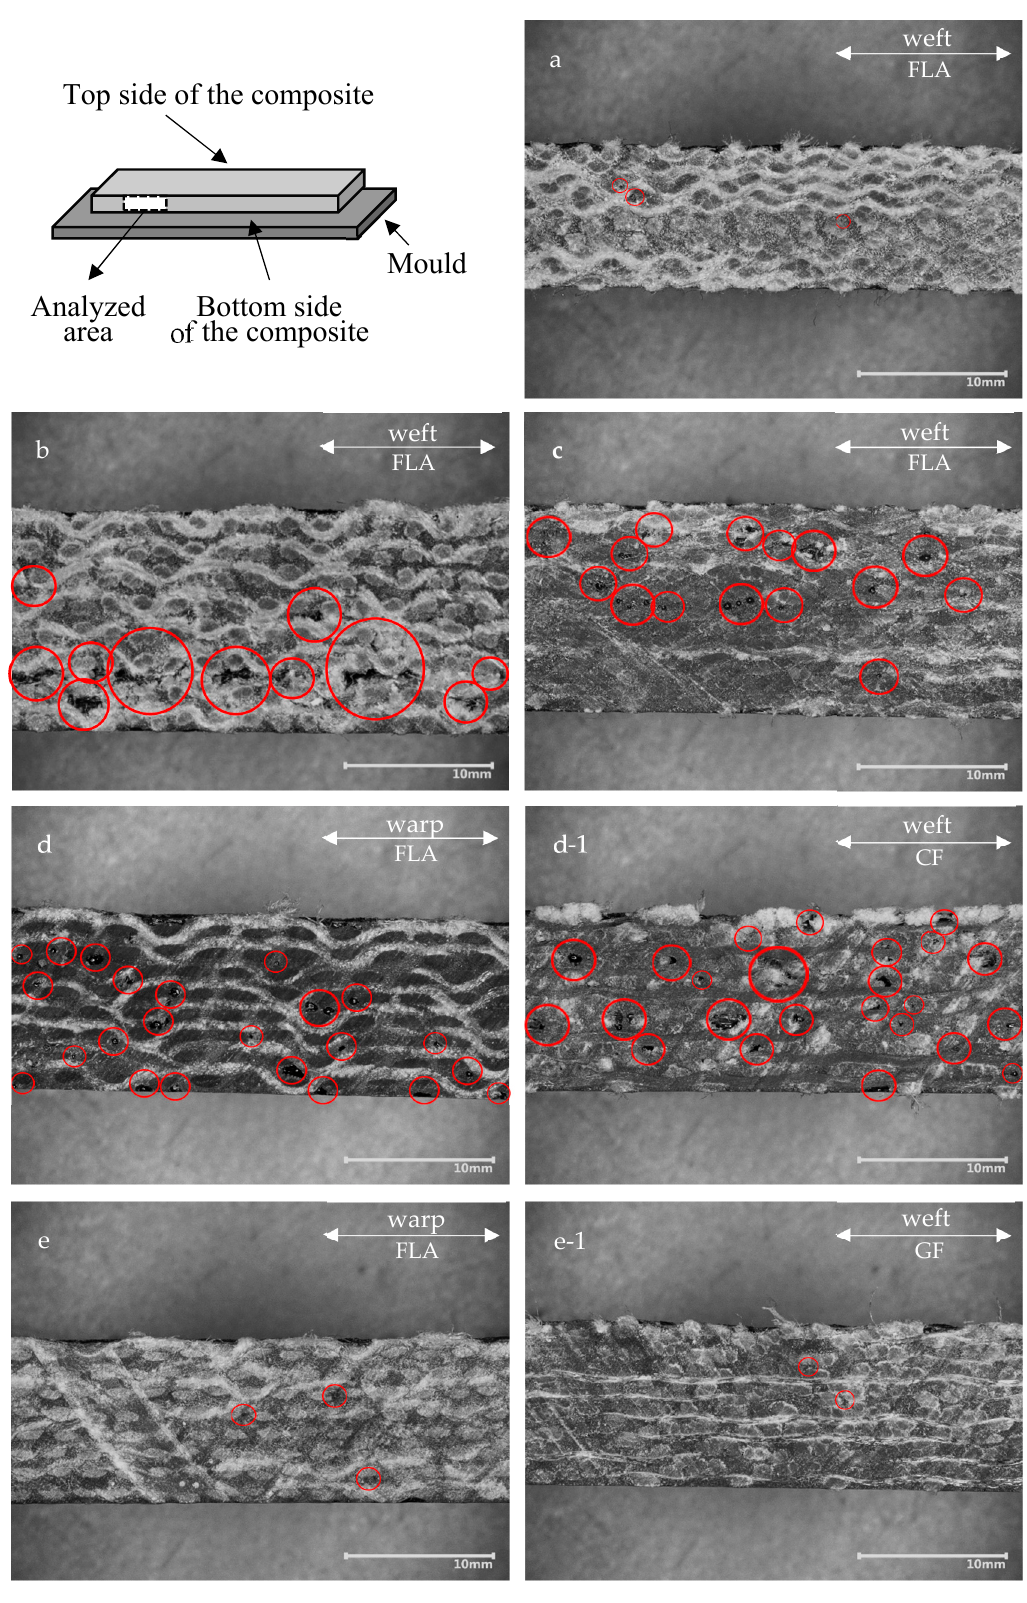
Figure 5. Digital microscope images of the cross sections of the flax composites with plain ( a ), twill ( b ) and satin ( c ) weaved textiles and hybrid textiles composing of carbon and flax ( d ) and ( d-1 ) as well as glass and flax ( e ) and ( e-1 ).